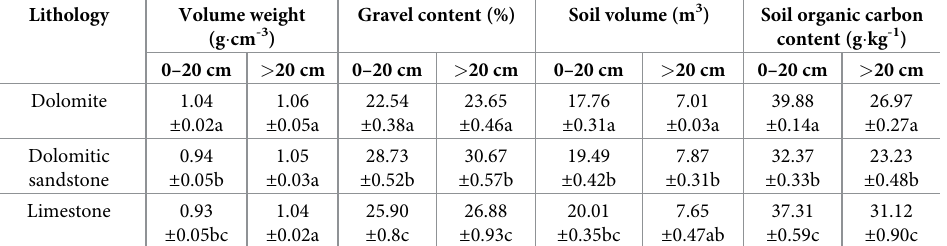
Table 8. Soil volume weight, gravel content, volume, and organic carbon content of bare ground under different lithologies.